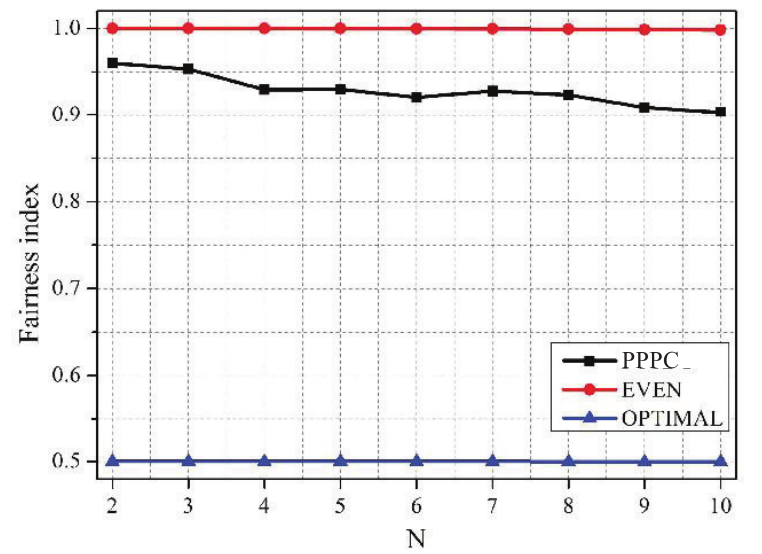
Figure 8. Fairness among sensors vs. N under schemes with different active probabilities of